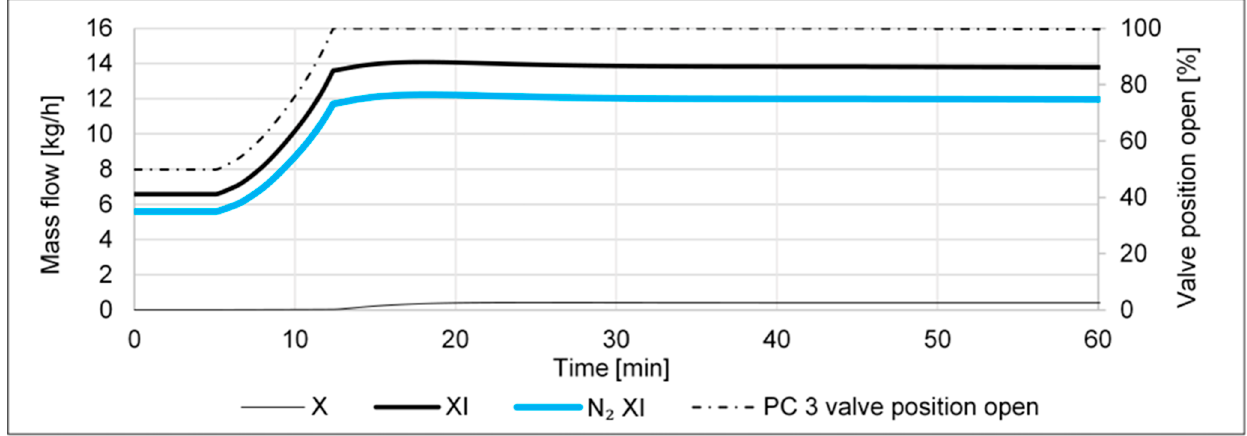
Figure 3 . Further mass fl ows and position of the recycle valve (right vertical axis) of scenario (a). Figure 3. Further mass flows and position of the recycle valve (right vertical axis) of scenario